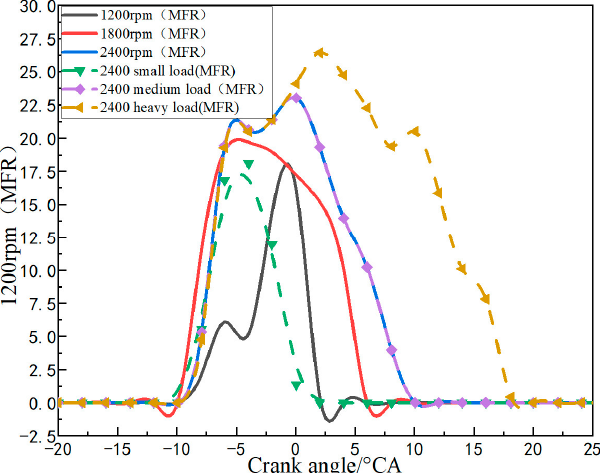
Figure 18. Injection Rate figure for each of the conditions. It can be seen from Figure 19 that the heat release rate of combustion in the cylinder decreases with the increase in engine speed, and the combustion duration is prolonged. When the engine speed increased from 1200 rpm to 2400 rpm, the combustion duration extended by 57%. The maximum temperature in the cylinder decreases with the increase of engine speed. It is mainly due to the decrease of the mass of the fuel-air mixture formed during the ignition delay, the decrease of the proportion of fuel-air premixed in the whole process, and the gradual increase of diffusion combustion with the increase of engine speed.